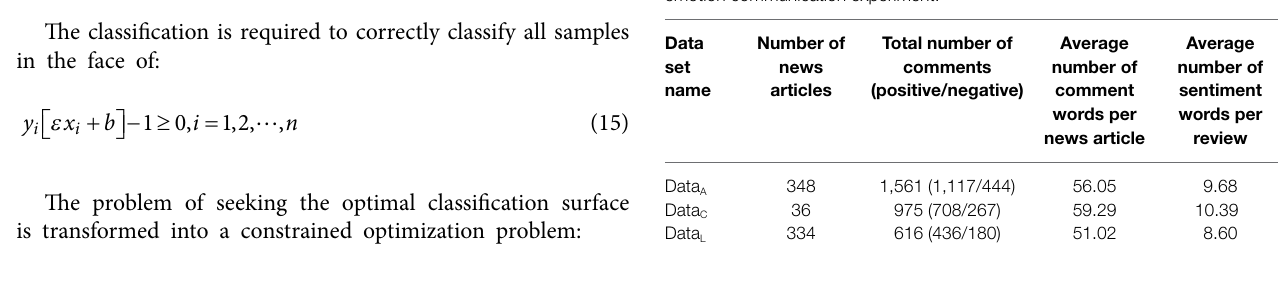
TABLE 1 | Statistical information related to the dataset used in the news emotion communication